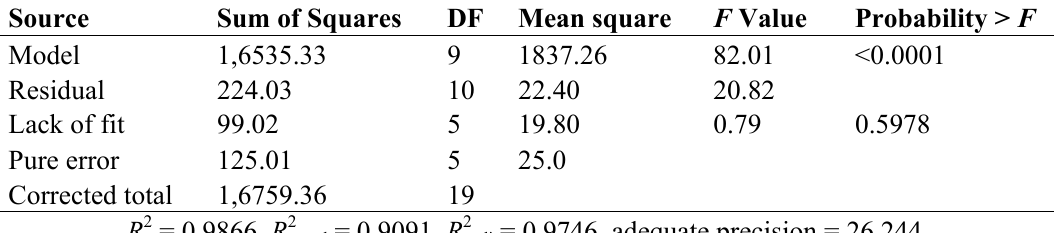
Table 2. Analysis of variance (ANOVA) for the quadratic model of lipase activity of Burkholderia